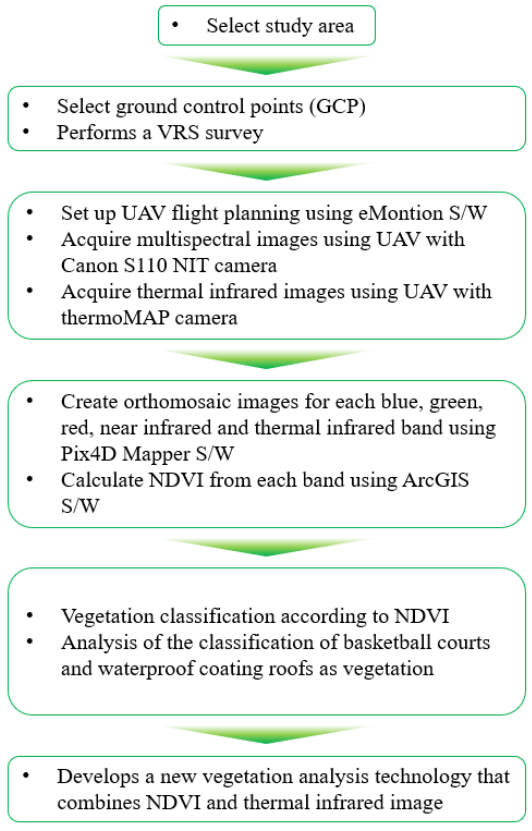
Figure 1. The research